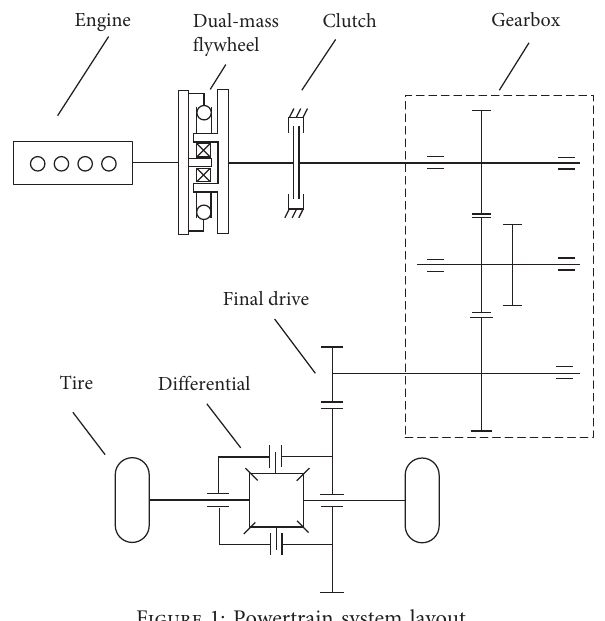
Figure 1: Powertrain system